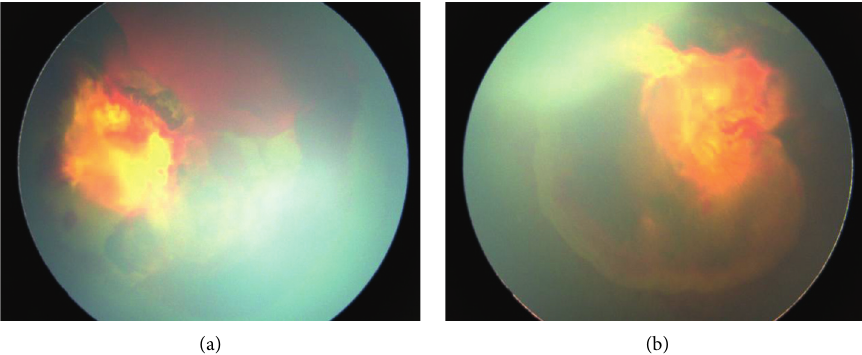
Figure 6: Colour fundus of case 5. (a) Right eye. (b) Left eye. Both eyes showed total retinal detachment with fibrosis and haemorrhage in front of the optic